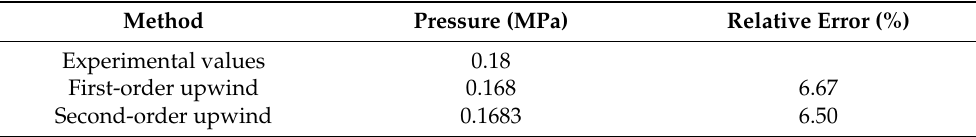
Figure 8. Schematic diagram of the monitoring points. Table 5. Comparison of the numerical simulation results with experimental results. Table 5. Comparison of the numerical simulation results with experimental